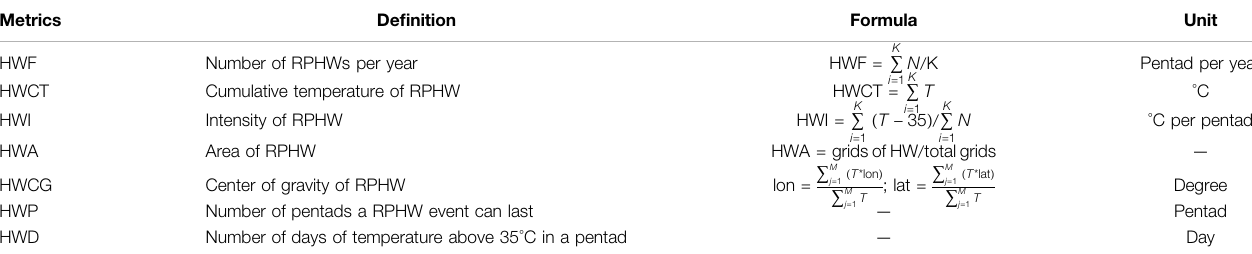
TABLE 1 | Details for RPHW.